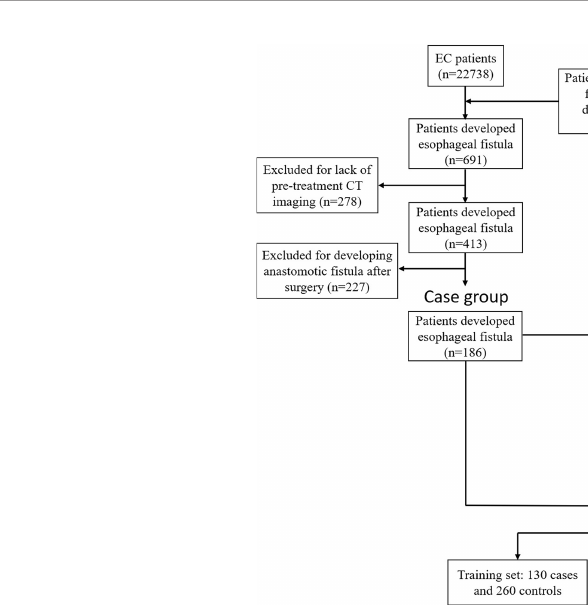
FIGURE 2 | The overall work fl ow of patients. We retrospectively screened 22738 patients, and fi nally 186 were enrolled in the case group and 372 in the control group. All patients were randomly divided into 70% (training set) and 30% (validation set). Key words esophageal fi stula or perforation, and esophageal cancer were set in the imaging system. After excluding duplicate patients, a total of 691 patients with esophageal fi stula were collected. Then, patients with lack of diagnostic CT (n=278) and with postoperative anastomotic leakage (n=227) were excluded. Finally, 186 esophageal fi stula patients were